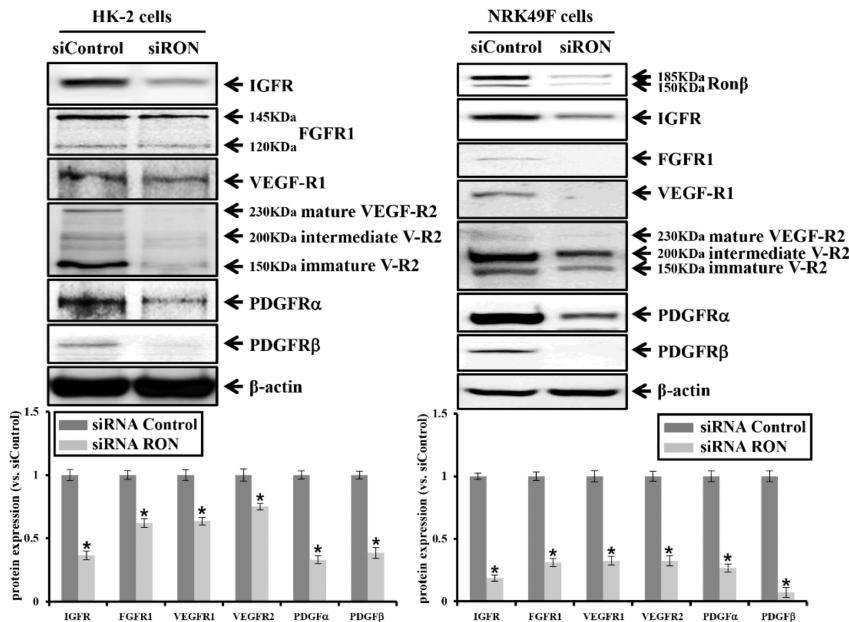
Figure 6. E ff ects of RON siRNA on RTKs in HK-2 and NRK49F cells. Protein expression of IGFR, FGFR1, VEGFR1, VEGFR2, PDGFR α , and PDGFR β by RON siRNA transfection was analyzed. Each column represents the mean ± SEM. * p < 0.05, compared with the siRNA